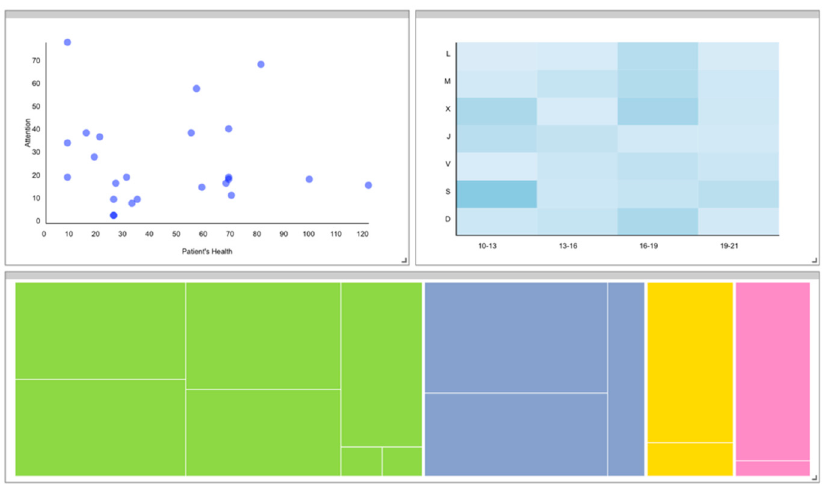
Figure 9. A dashboard prototype that follows the described